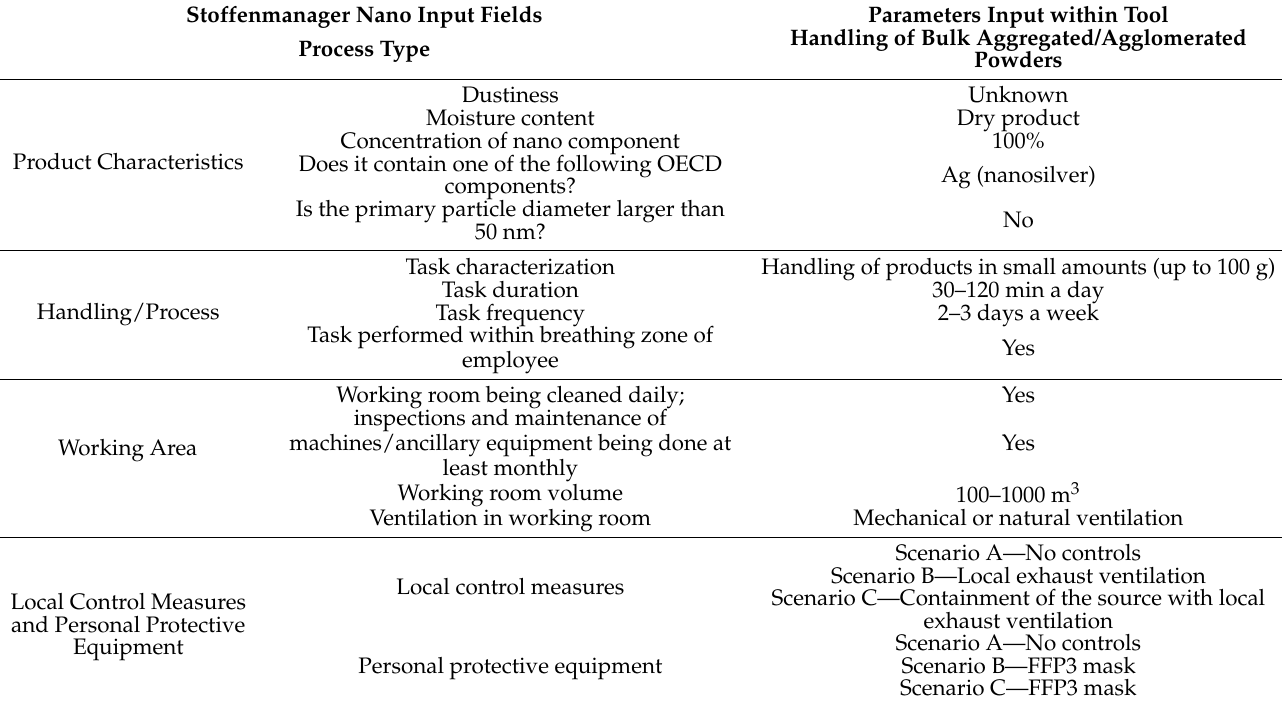
Table 4. Input parameters in the Stoffenmanager Nano for silver nanoparticle hazard